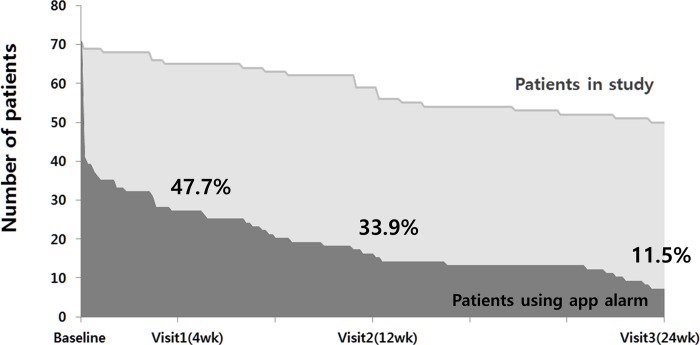
Application usage rate for the mobile group (patients using the app alarm/patients in the study).